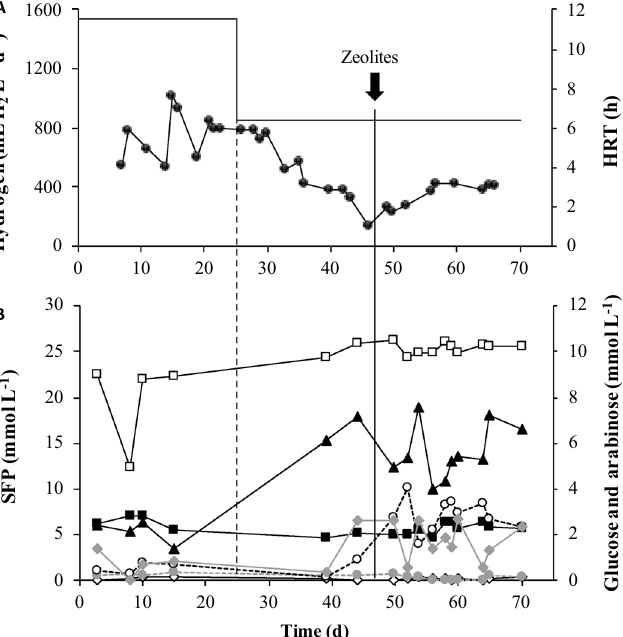
Figure 3. Effect of HRT and zeolite (Z/I 0.26 g g −1 ) on the bioreactor performance treating arabinose and glucose. ( A ) …… Hydrogen production rate and HRT. ( B ) …… Arabinose and ….. glucose consumption and soluble fermentation products (SFP): ……. Formic acid; ……. Acetic acid; Lactic acid; …… n-butyrate acid; ……. Propionate acid.